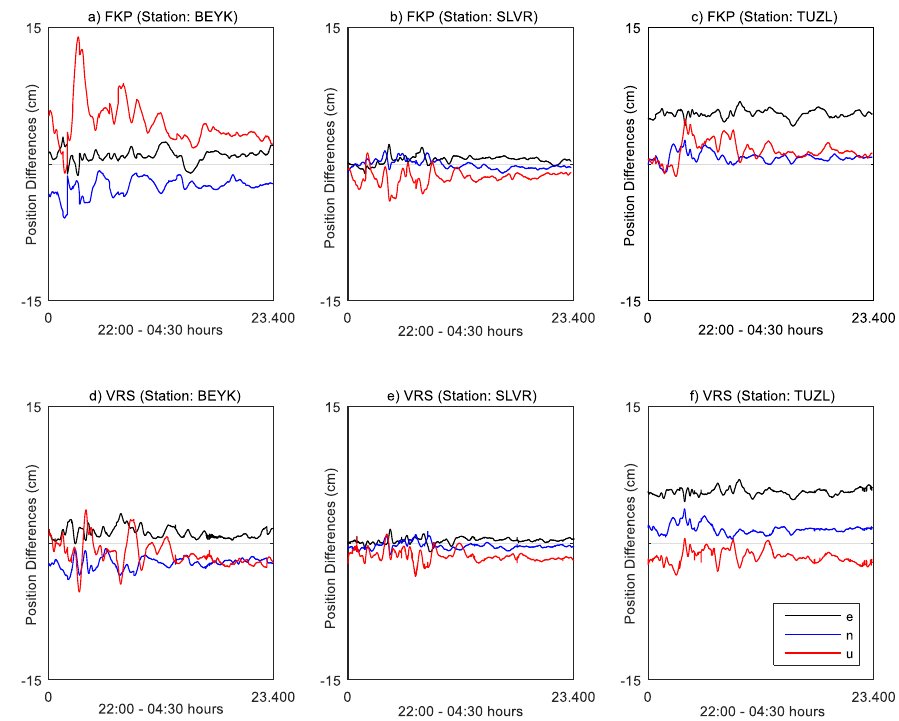
Figure 7. The NRTK position differences at stations with a long baseline length ( a , b and c are FKP results. d , e and f are VRS results).